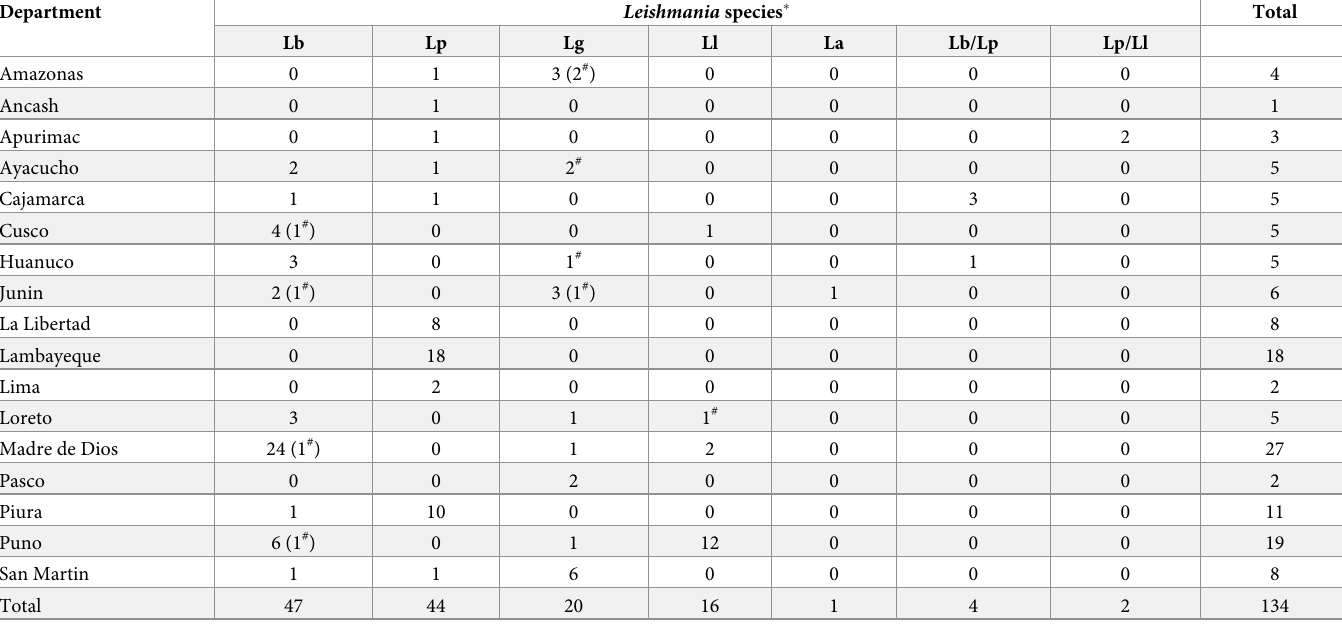
Table 1. Distribution of Leishmania species by department in Peru.